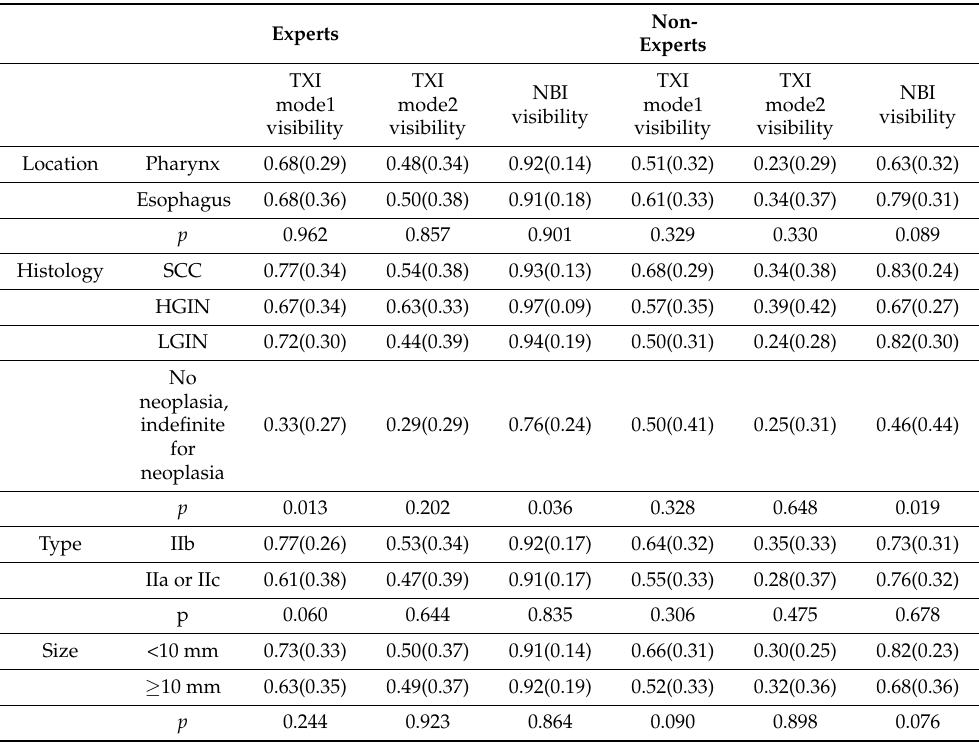
Table 5. The results of the subgroup analysis for visibility scores by location, histology, macroscopic type, and